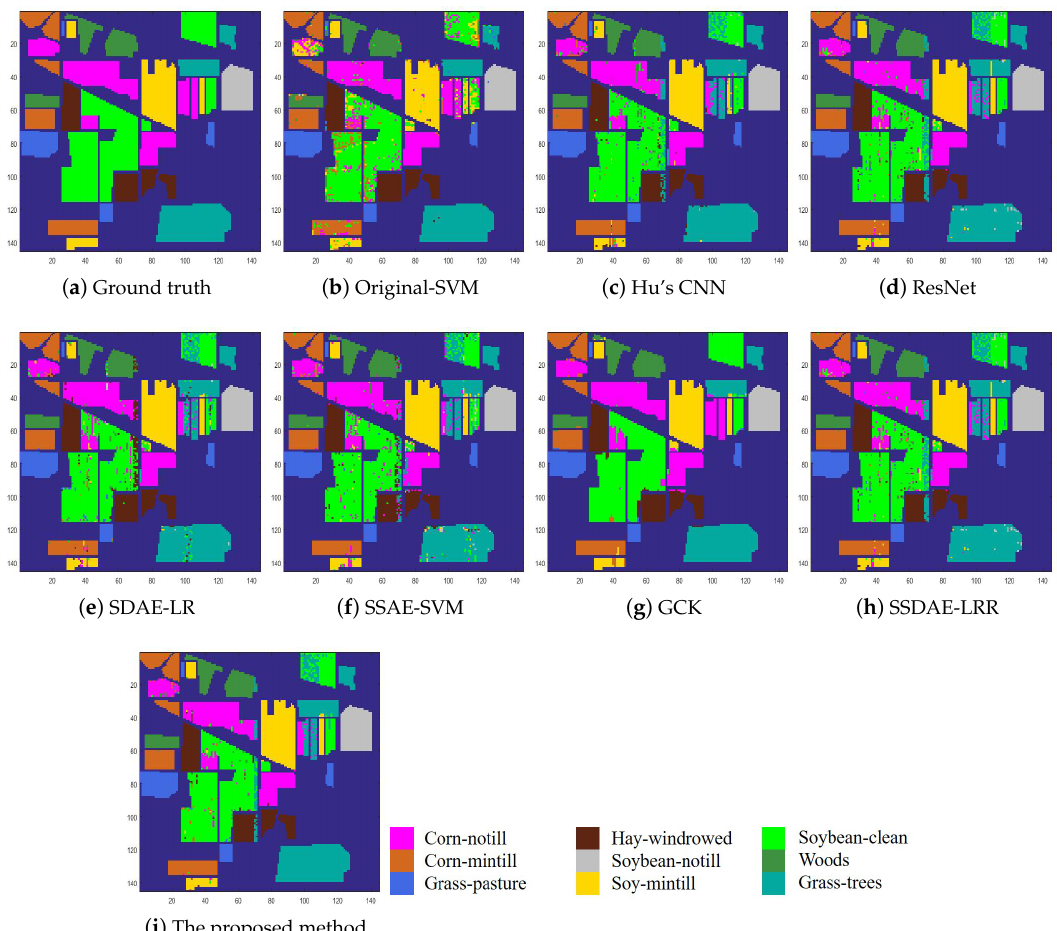
Figure 9. Classification maps of different methods on Indian Pines dataset (a total of 1800 labeled samples were used for